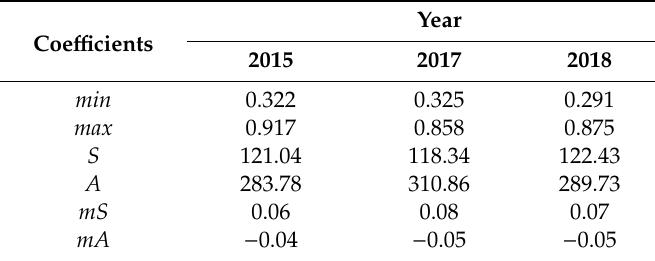
Figure 2. NDVI time series (grey circles) and fitted double-logistic curves (solid black line) for three years in a black spruce boreal stand of Quebec, Canada. Each day of the year shows the mean NDVI values for 40 black spruce stands used for model calibration. Table 1. Coefficients of the double-logistic function fitted to three years of MODIS NDVI values extracted for 40 pure black spruce boreal stands in Quebec, Canada. min and max represent minimum and maximum NDVI, S and A represent timings of the inflection points and rates of change at the inflection points represented by mS and mA .